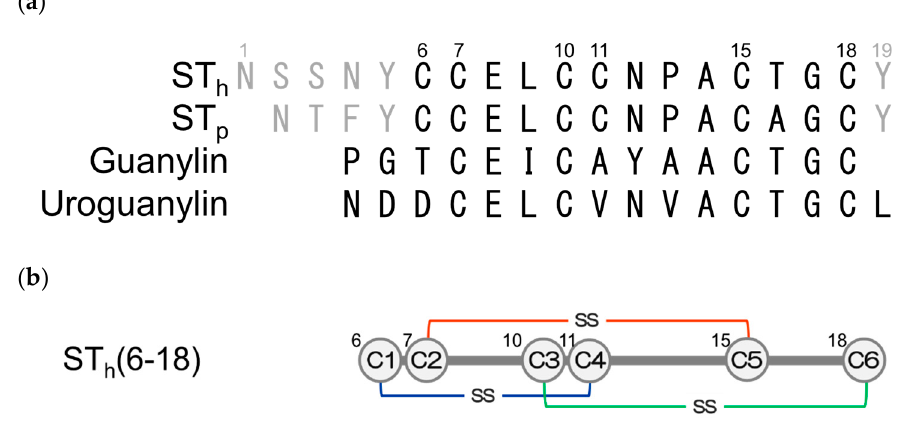
Figure 1. ( a ) Amino acid sequences and disulfide linkages of ST h and ST p produced by a human and a porcine strain of enterotoxigenic E. coli , respectively. ( b ) The schematic drawing of ST h (6–18). The Cys6, Cys7, Cys10, Cys11, Cys15, and Cys18 residues were represented by C1, C2, C3, C4, C5, and C6, respectively.